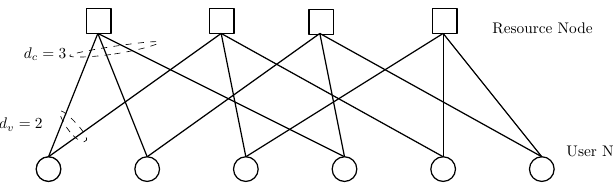
Figure 2. Bipartite graph of 4 resources and 6